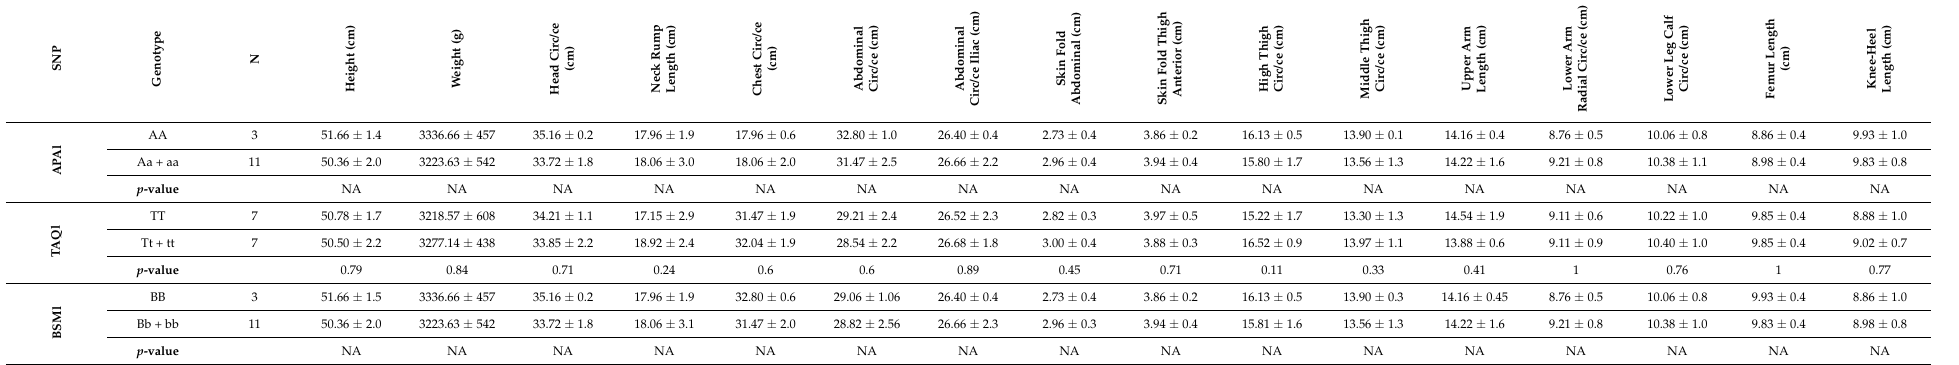
Table 5. Birth neonatal anthropometry (neonatal vitamin D status at birth >50 nmol/L) according to neonatal VDR